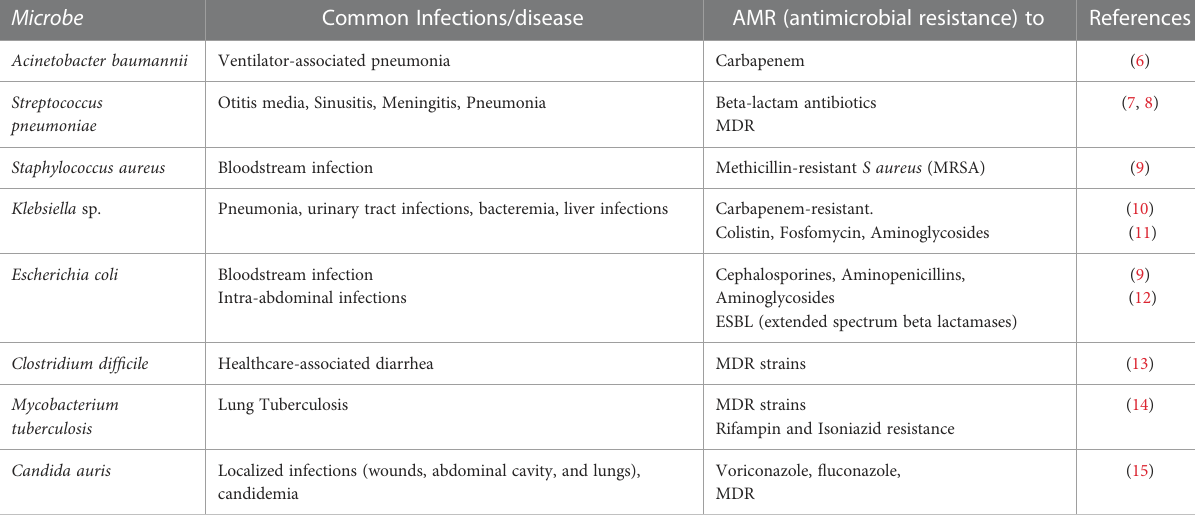
TABLE 1 Examples of infections with known antimicrobial resistance.